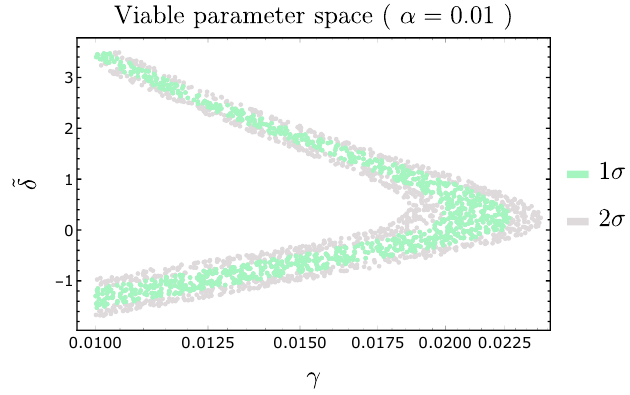
Figure 8 . We randomly sample points in the same parameter range as figure 7 (i.e. fixing α = 0 . 01 ) and select the ones within the 1 σ (green) and 2 σ (grey) Planck confidence contours. The corre- sponding values for ˜ δ and γ are shown. In the region ˜ δ > 0 the points corresponds to inflationary trajectories of the type shown in figure 6 ending up in the false minimum at φ 1 = 2 π/c 1 , φ 2 = −O (˜ δ ) . In the complement ˜ δ < 0 the points correspond to trajectories which in figure 6 start with φ 2 -values beyond the saddle point, and end up in the true minimum at φ 1 = φ 2 = 0